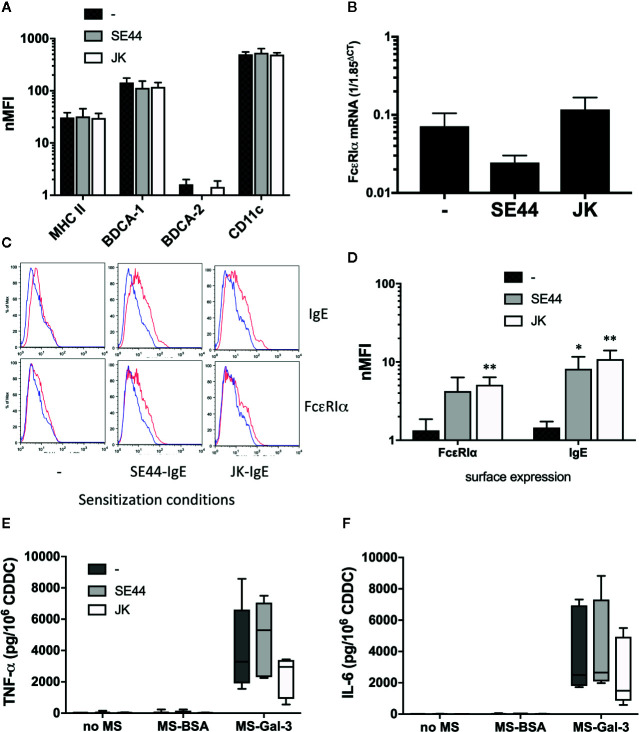
IgE expression by culture-derived dendritic cell (CDDC) is not required for Gal-3-dependent activation. CDDC were grown from CD34+ precursors, as described in the Materials & Methods section. CDDC were then portioned, with one-third passively sensitized with JK-IgE, one-third with SE44-IgE (both at 2 μg/ml), and one-third left untreated. After 3d incubation, cells from all three conditions were washed and analyzed for the following: (A) phenotypic markers, (B) mRNA expression for FcεRIα, (C, D), expression of FcεRIα protein & IgE, and (E, F), induction of TNF-α and IL-6, respectively, after 20 h co-culture with MS-BSA, MS-Gal-3, or no MS. All bar graphs are the Mean ± SEM, n = 4. *P<0.05, **P<0.01.